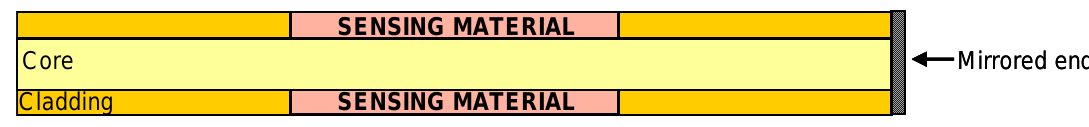
Figure 18 . This configuration, compared to the classic transmission one, enhances the sensing performance of the sensors because the incident light passes twice through the sensing zone due to the mirrored end. Also, the size of the sensor head is reduced